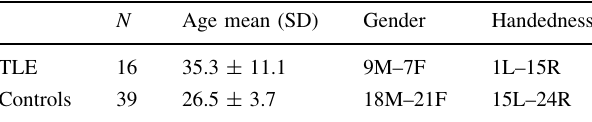
Table 1 Demographic information of participants, patients (TLE, patient with epilepsy with left temporal lobe epilepsy) and healthy volunteers (controls) N Age mean (SD)